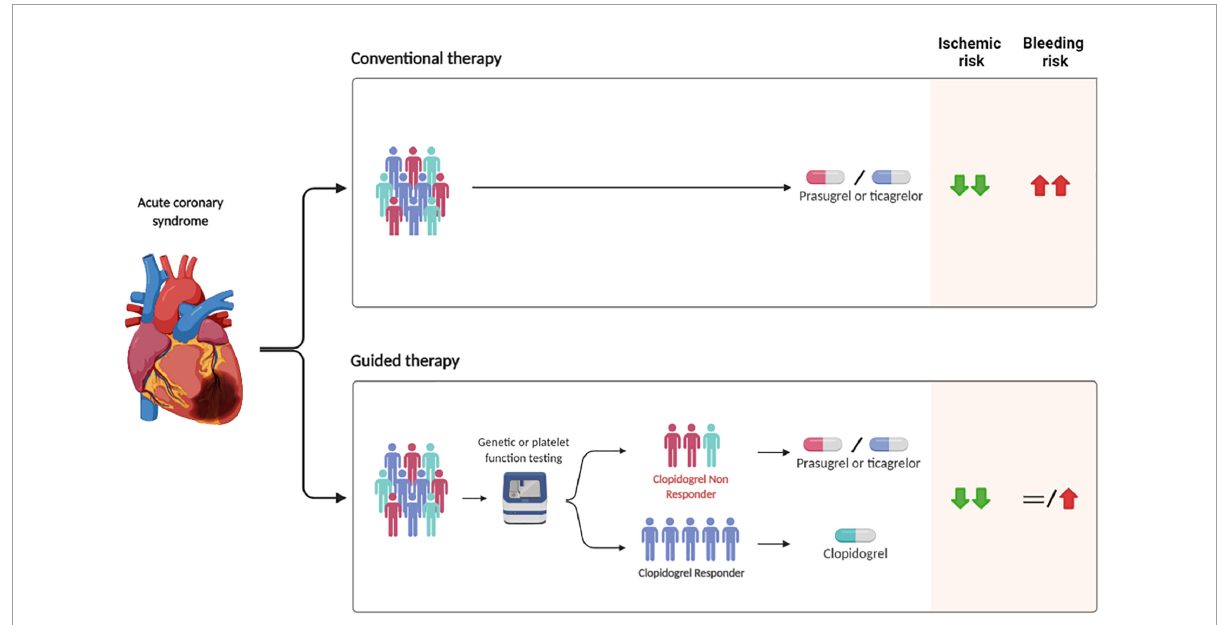
FIGURE2 Safety and efficacy of guided vs. conventional selection of P2Y 12 inhibitors in patients with ACS undergoing PCI. PCI, percutaneous coronary